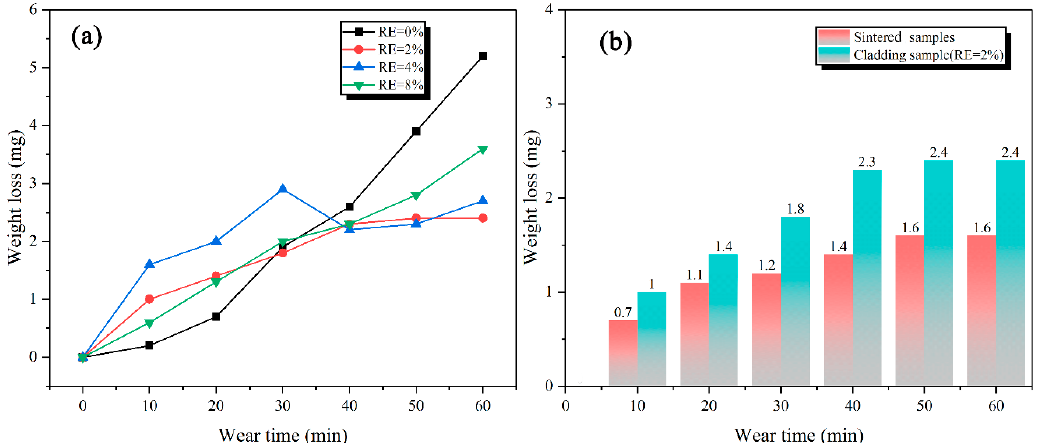
Figure 11. Wear weight-loss of claddings with different RE contents and sintered sample. ( a ) Wear weight-loss of claddings with different RE contents; ( b ) comparison of the wear weight-loss between the sintered sample and cladding with 2% RE content.